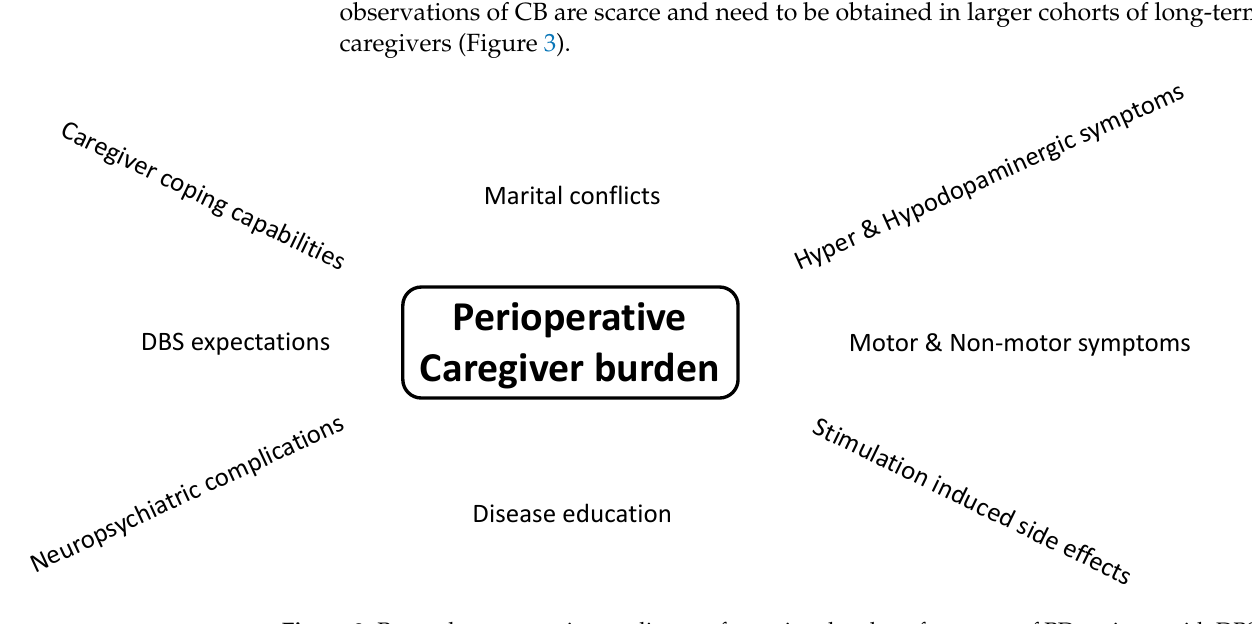
Figure 3. Pre-and postoperative mediators of caregiver burden of partners of PD patients with DBS. 4. Caregiver Burden in PD Patients with Globus Pallidus Internus Stimulation The globus pallidus internus (Gpi) is an alternative DBS target for PD patients besides STN implantation as the Gpi is supposed to have a lower risk of dysarthria, neuropsychi- atric complications and impaired cognition [61]. The discussion of the favorable target in PD is still controversial [61]. There is also scarce information on caregiver burden in Gpi patients [31,62]. In a cohort with 275 DBS patients, including PD patients implanted both in STN and Gpi, caregiver burden measured by the Multidimensional Caregiver Strain Index (MCSI) was associated with PD age at surgery and interval since surgery [31]. Overall, QOL increased in this specific DBS cohort, whereas CB did not [31]. In a parallel two-arm clinical trial with 44 DBS patients, of which 81% were implanted in the Gpi, postoperative home health management with standard of care (SOC) postoperative management was compared [62]. In this cohort, caregiver burden measured by MCSI was reduced in both groups 6 months after surgery [62]. Interestingly, the MCSI was more reduced in the SOC than in the home health group, although the result did not reach significance [62]. In a large multicenter study on 1835 PD patients with a ≥ 10-year disease duration, 411 patients with DBS were included without further distinction of DBS targets. QOL worsened parallel to increased CB, which can mostly be explained by more severe symptom severity in advanced PD stages [63]. In summary, it appears that CB of partners of PD patients with STN and Gpi is mostly reduced shortly after DBS implantation but can increase over time with disease progression and reduced QOL. Further research in larger cohorts is needed on CB in caregivers of PD patients with Gpi